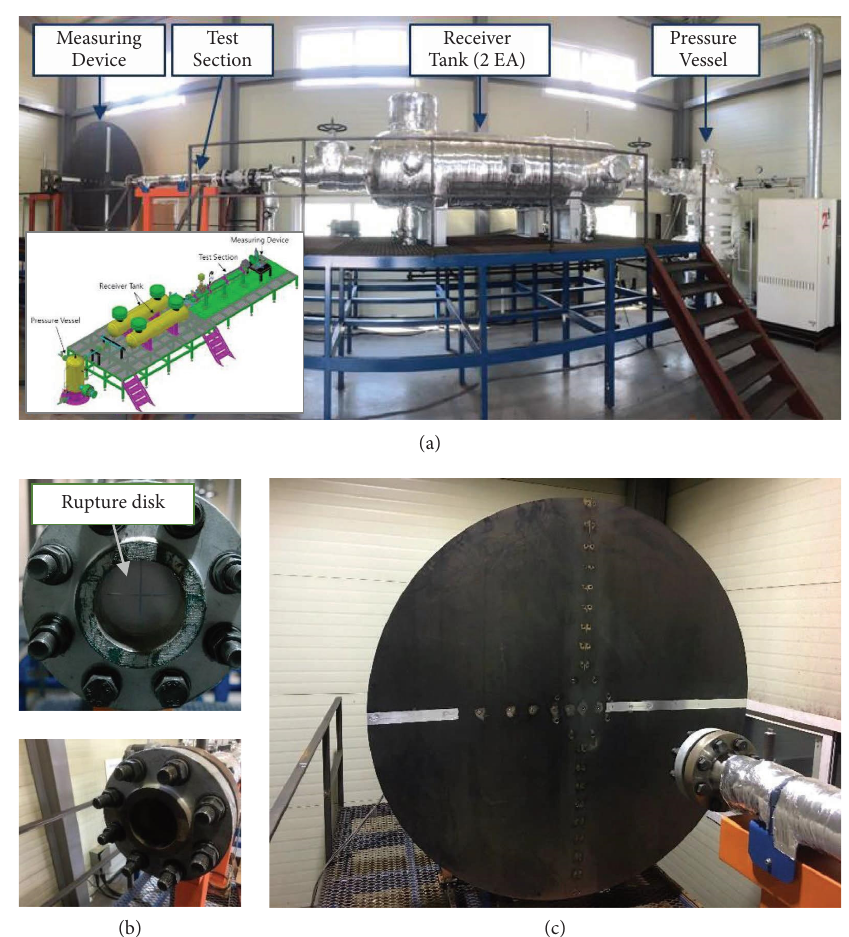
Figure 3: Experimental setup: (a) experimental facilities, (b) test section, and (c) measuring